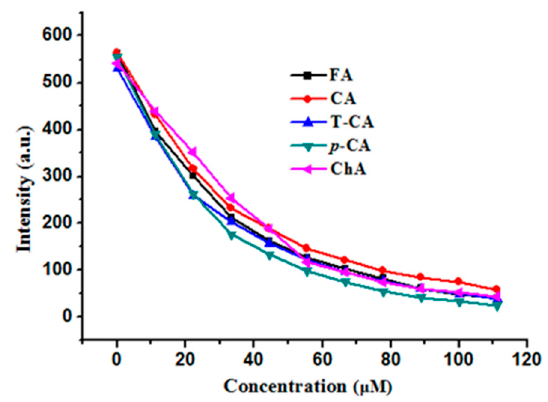
Figure 4. Comparison of cinnamic acids on the fluorescence quenching of apo rH-2. Conditions: 0.55 µ M rH-2 in 50 mM Tris-HCl, [phenolic acids] = 0–110 µ M, pH 7.0, 25 ◦ C. λ Ex = 280 nm, slits for excitation and emission are 5 nm and 10 nm.